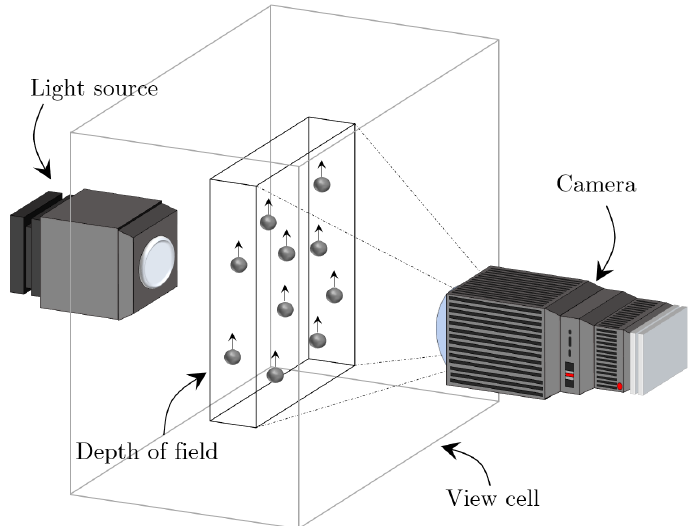
Figure 3. The depth of field of the measured volume within the view